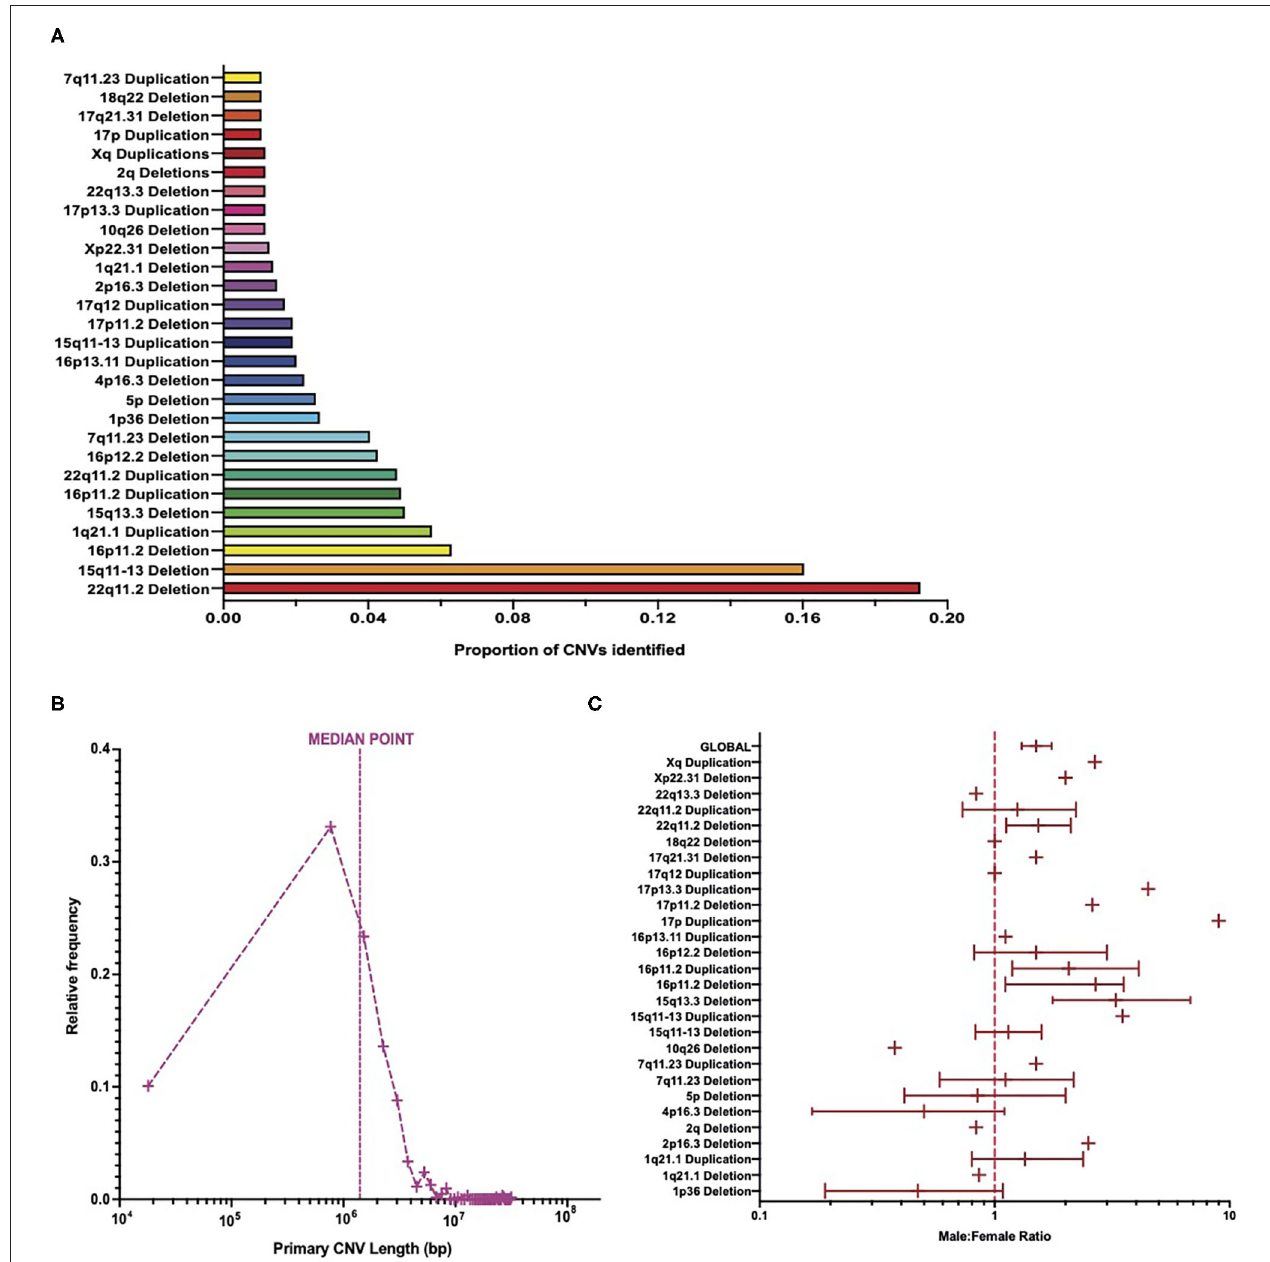
FIGURE 2 | Burden of copy number variants across cohort. (A) The number of patients with each CNV type in comparison to the total number of CNVs. (B) Frequency distribution of primary CNV identified in patients equating to the total number of primary CNV lengths identified, on a logarithmic axis, with a line signifying the median point. (C) Meta-analysis of cohort sex ratio on a logarithmic axis, broken down by each CNV type, with 95% confidence intervals calculated for CNVs ≥ 20 patients (and global value) via bootstrapping with N = 1,000 samples. CNV, copy number variant.